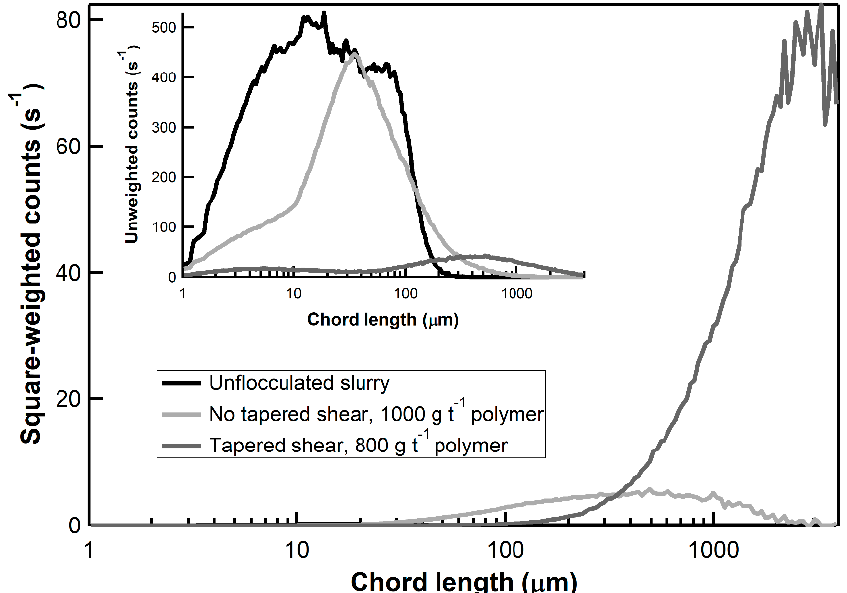
Figure 11. Effect of tapered shear on the unweighted and length square-weighted chord length distributions from focused beam reflectance measurement (FBRM) monitoring of 20 wt % kaolin slurry treated with a high molecular weight (MW) polyacrylamide (PAM) ([ η ] 17.2 dL g − 1 ).